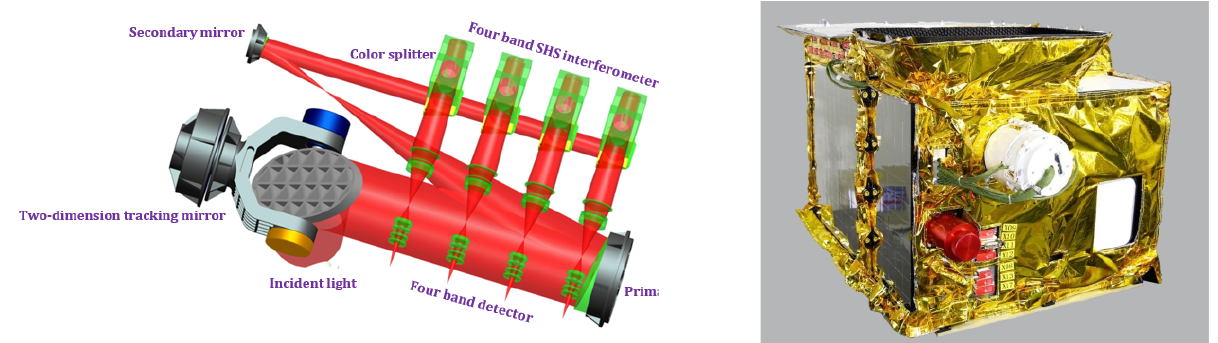
Figure 1. Composition of the GMI payload optical system ( left ) and physical photos ( right ).